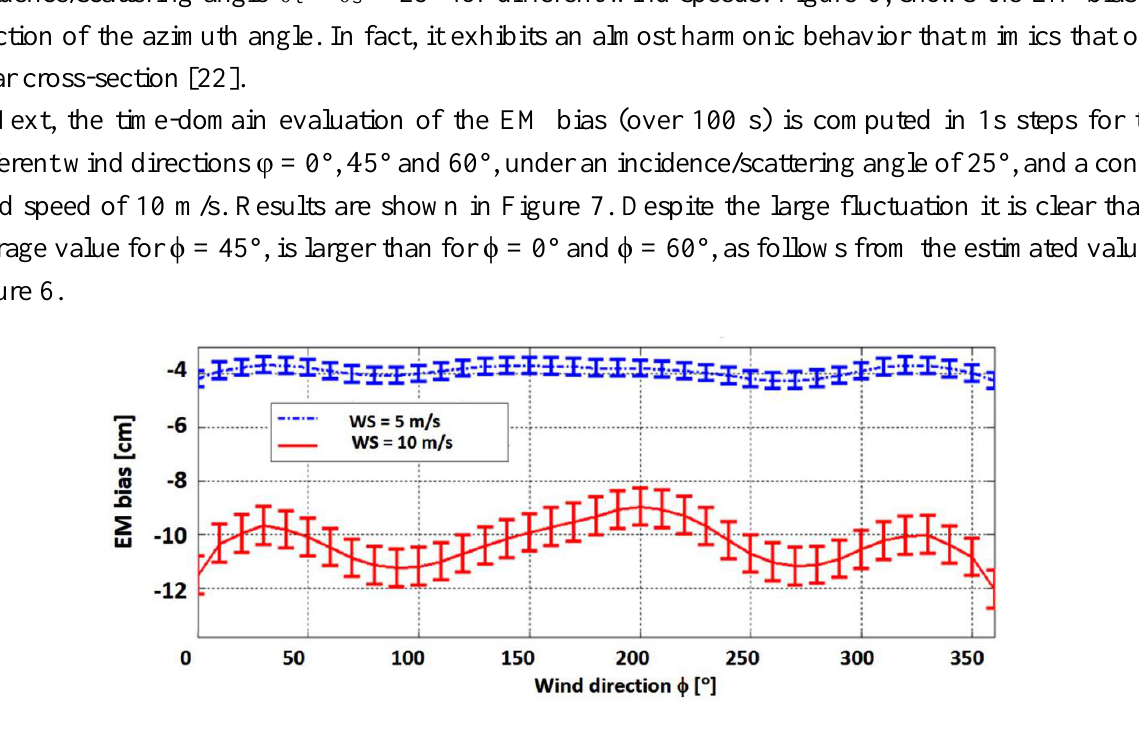
Figure 6. Impact of wind direction on EM bias from an incidence/scattering angle θ I = θ s = 25° and two different wind speeds (modified from [4]). R R